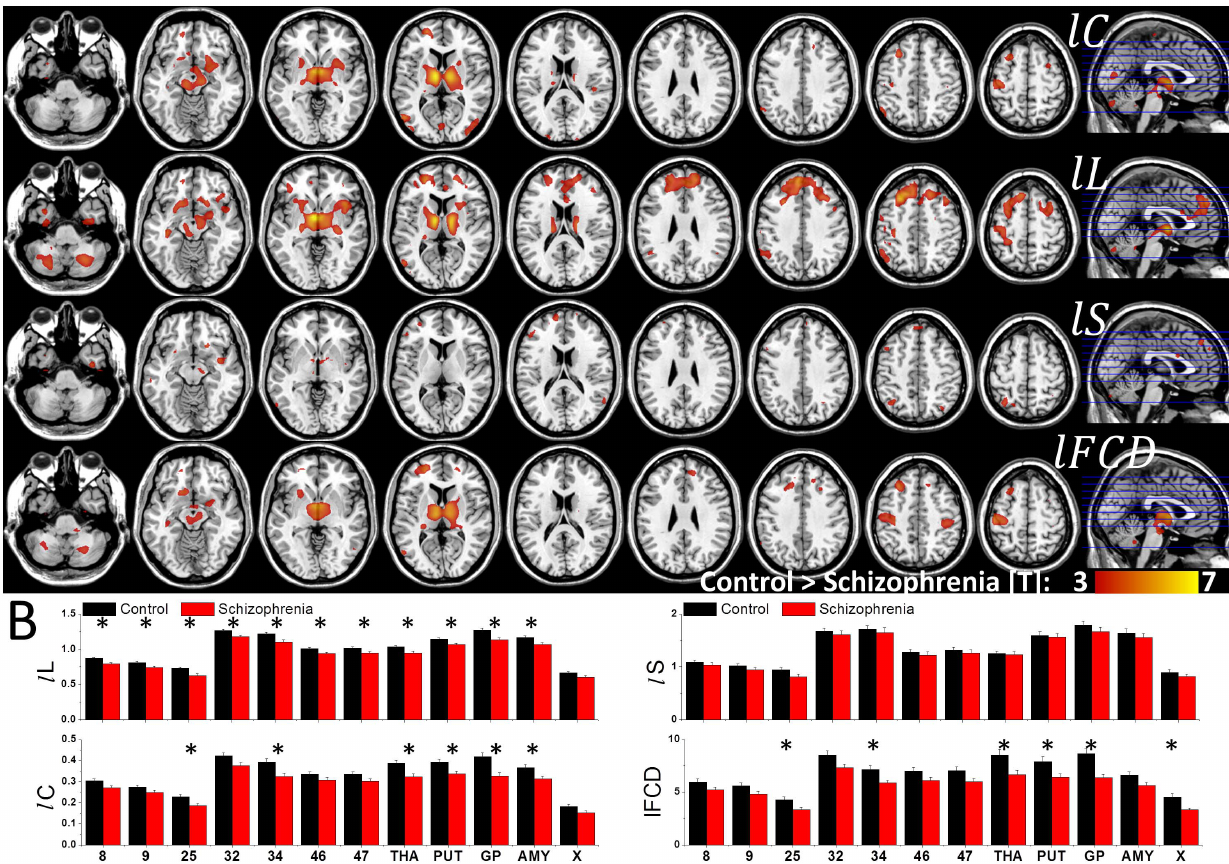
Figure 7. Reduced clustering, path length and local degree in schizophrenia. (A) Statistical significance of lower graph theory measures for 69 schizophrenia patients than for 74 healthy controls superimposed on axial views of the human brain. (B) Average values of the graph theory measures in anatomical ROI that demonstrated significant differences in the measures between patients and controls. X-axis labels: Brodmann Areas (number labels), thalamus (THA), putamen (PUT), globus pallidus (GP), amygdala (AMY) and the posterior lobe of the cerebellum (lobe X). Correlation thresholds: R T1 = 0. 50; R T2 = 0.65.